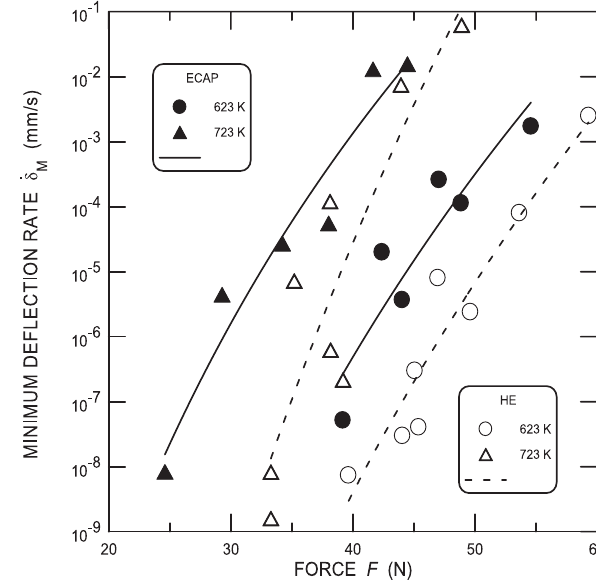
Fig. 20: Microstructure of the material after ECAP